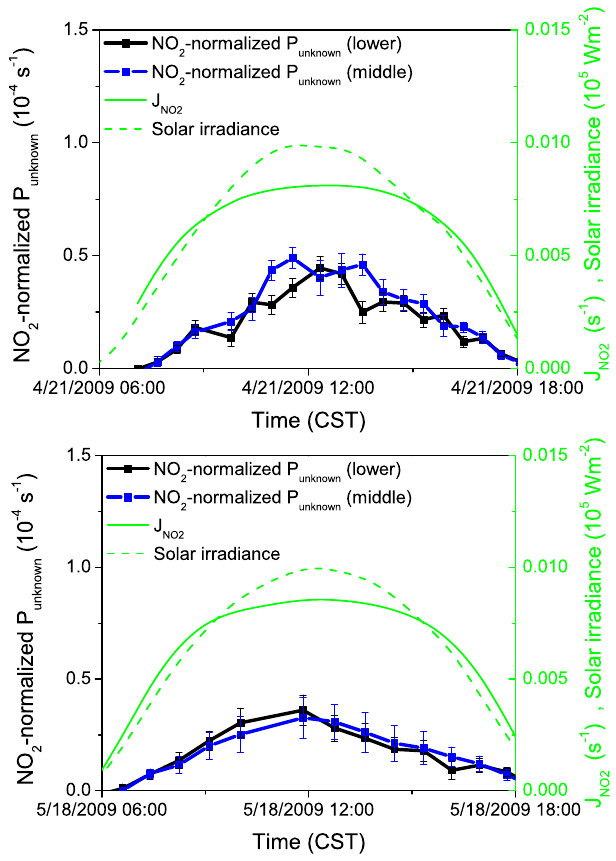
Fig. 6. Timeseries of NO 2 normalized P unknown in the lower and middle height intervals on 21 April 2009 (upper) and 18 May 2009 (lower). Photolysis frequency of NO 2 and solar irradiance are shown as well for comparison.